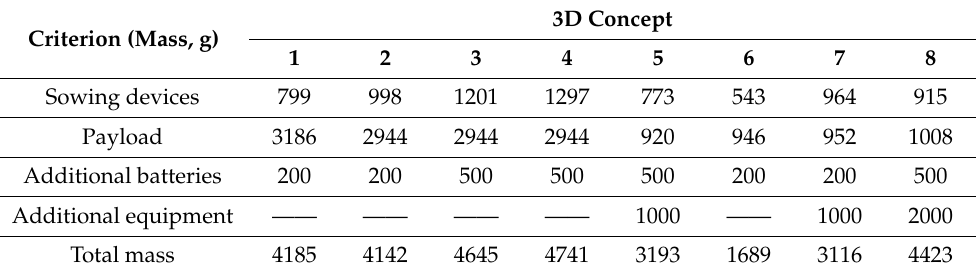
Table 3. Evaluation of various concepts by mass.